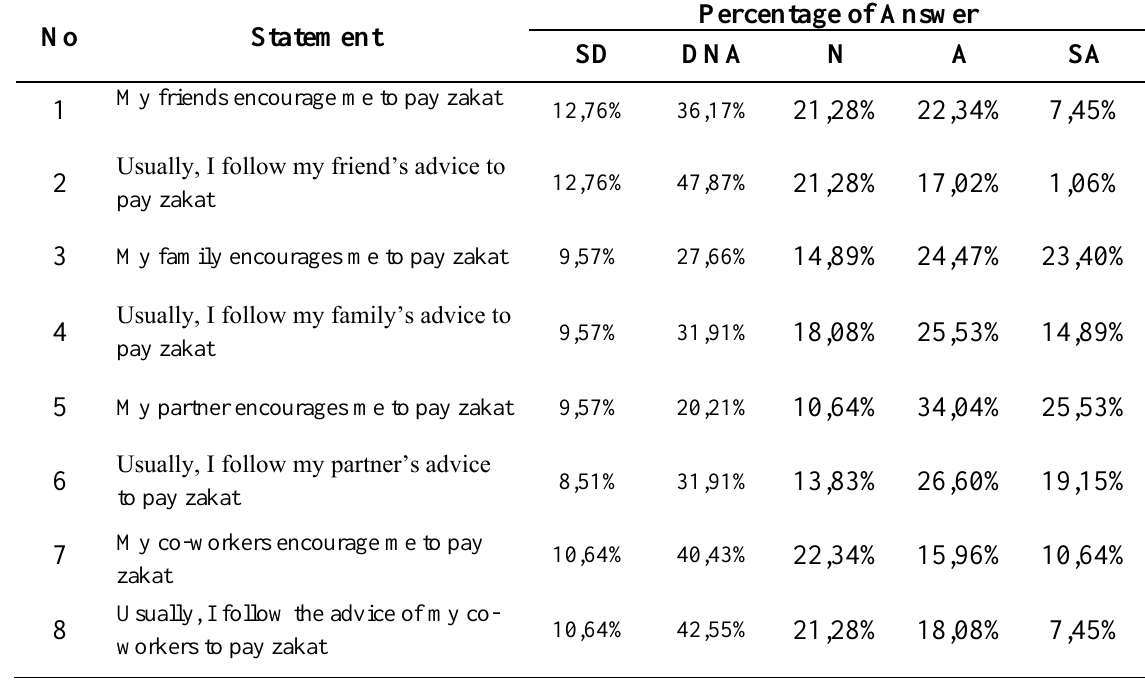
Table 4: Description of Subjective Norm